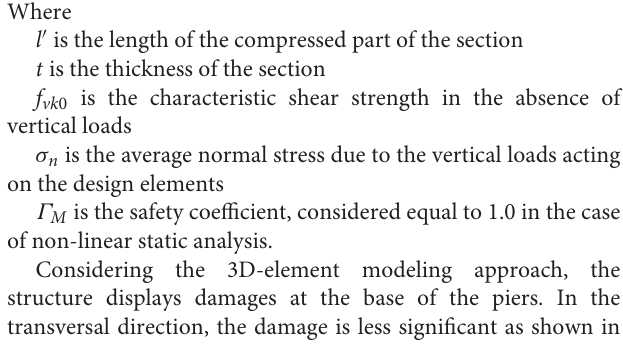
Frontiers in Built Environment |